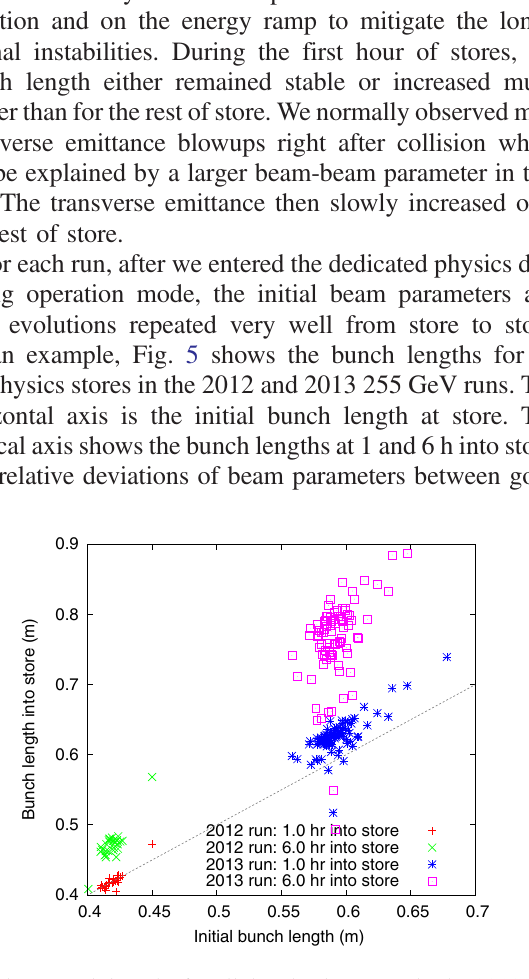
FIG. 5. Bunch lengths for all the physics stores in the 2012 and 2013 255 GeV runs.